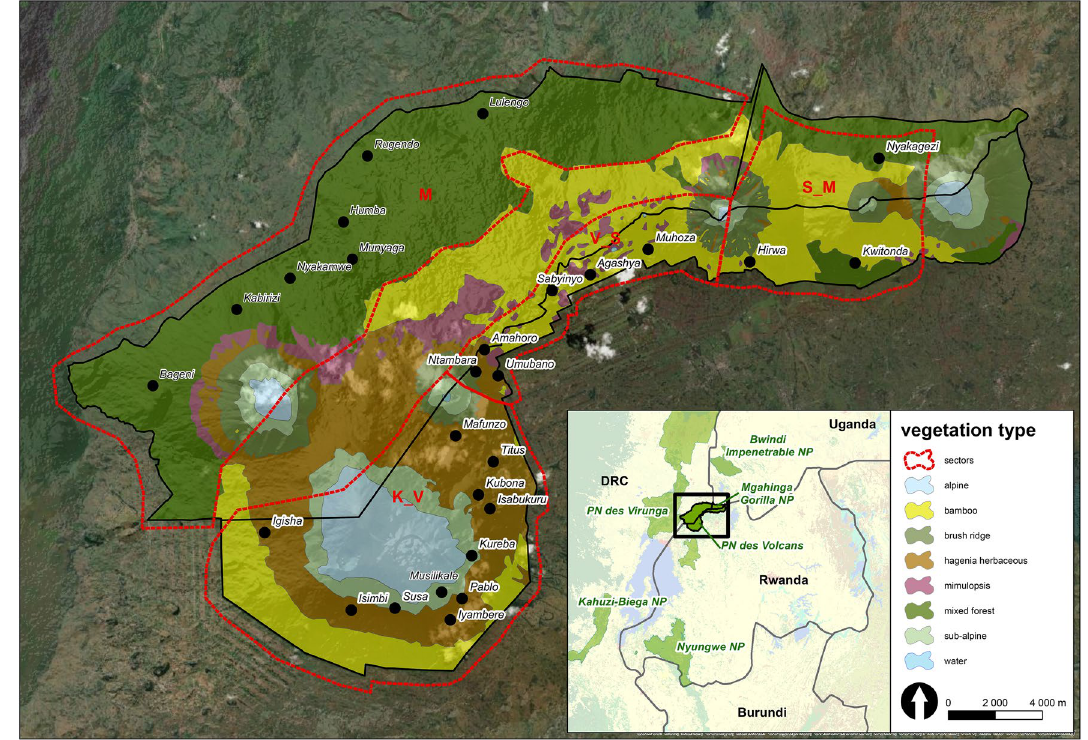
Figure 1. Division of the Virunga Massif into four areas according to volcano positions (M: Mikeno, Virunga National Park; K_V: Karisimbi–Visoke, Volcanoes National Park; V_S: Visoke–Sabyinyo, Volcanoes National Park; S_M: Sabyinyo–Muhavura, Mgahinga Gorilla National Park, Volcanoes National Park) with vegetation zones (based on Robbins et al. 5 ) and distribution of the studied groups. Map was created using ArcGIS Desktop 10.6 (ESRI 2019. ArcGIS Desktop: Release 10.6. Redlands, CA: Environmental Systems Research Institute; esri. com). Vegetation data were adopted according to Robbins et al. 5 ; boundaries of protected areas were derived from ProtectedPlanet.net